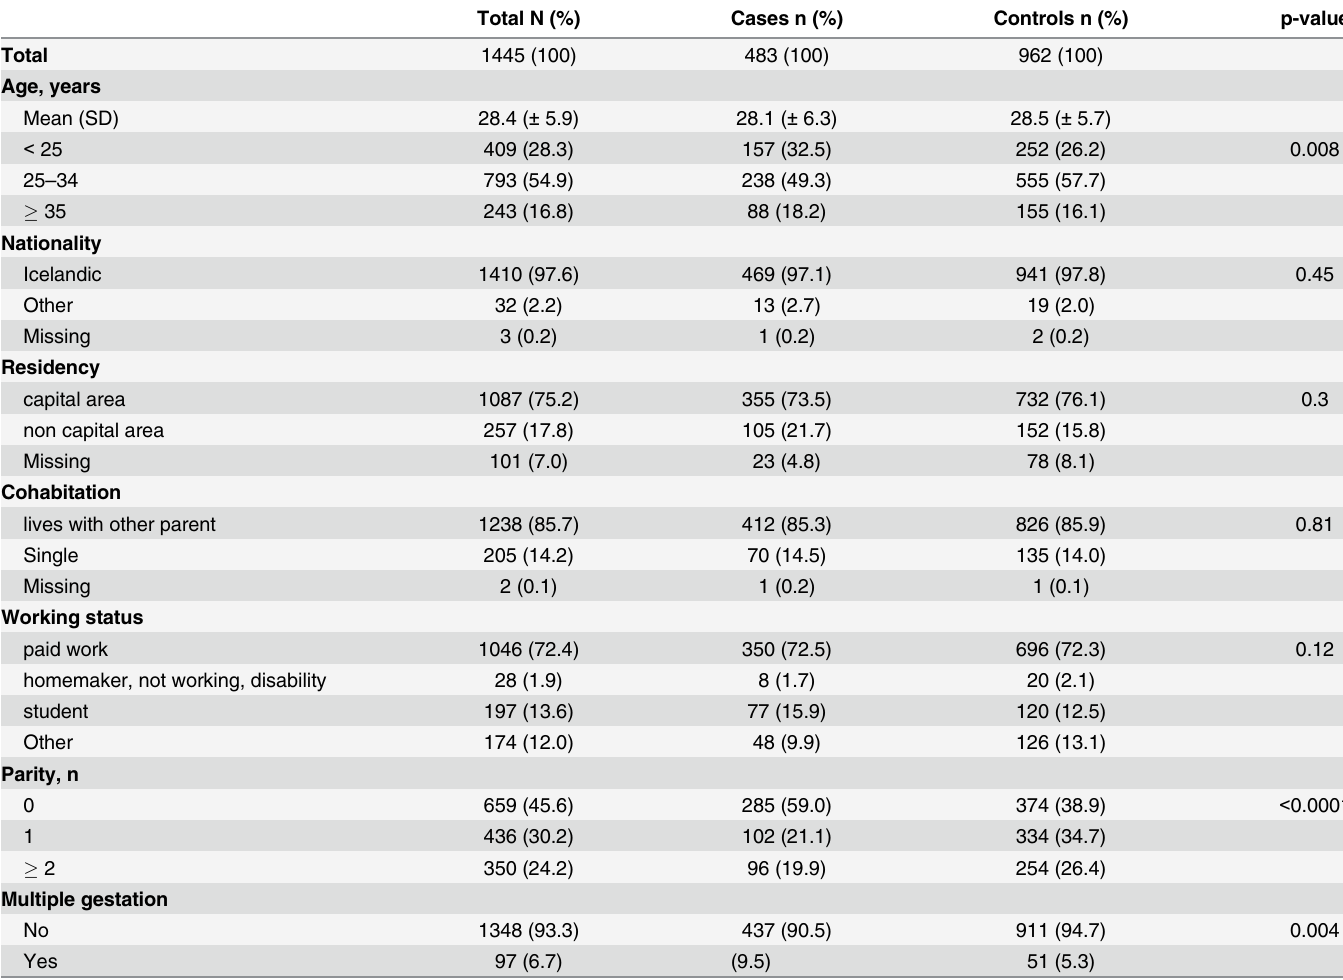
Table 1. Demographic and Pregnancy Characteristics of Cases and Controls *